Question: Summarize what this figure shows in one sentence.
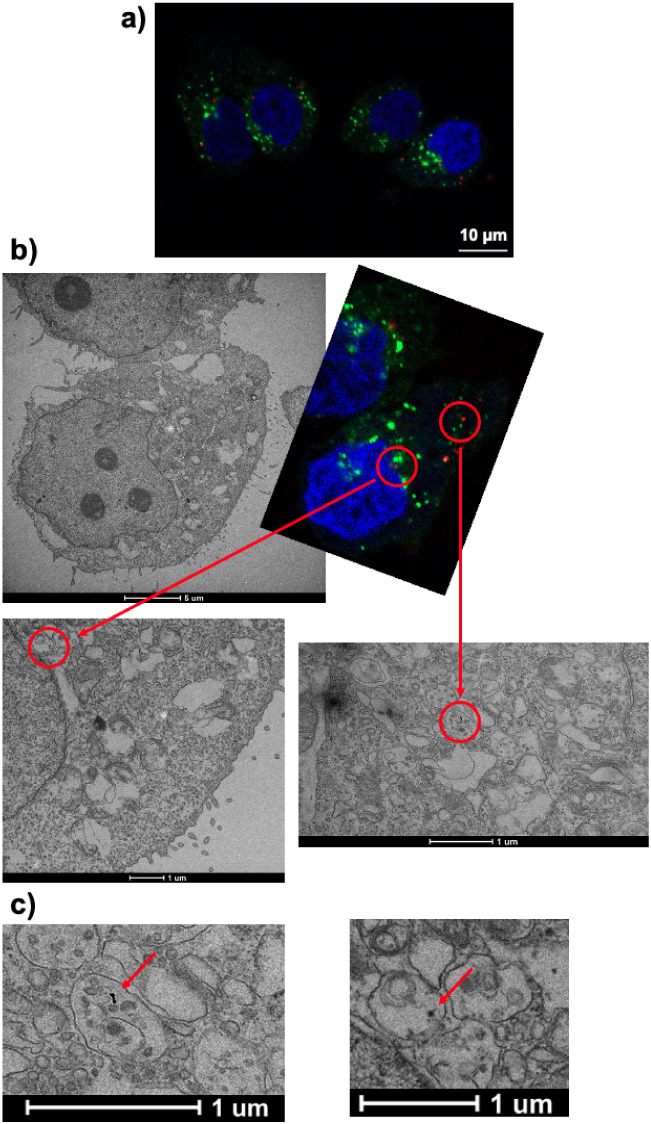
Answer: a) Confocal imaging of HeLa cells incubated with DiD’-Lipo-Gold for 1 h. Blue: nuclei; green: VPS35-GFP; red: DiD’-Lipo-Gold (single central slice from multiple 0.5 μm z-slices). b) Fluorescence and EM images of the cell of interest side by side, with correlation between red signal and presence of AuNPs in endosomal structures indicate by red circles. c) Higher-magnification images of the selected regions, highlighting AuNP-containing endosomal compartments corresponding to the fluorescence signal.